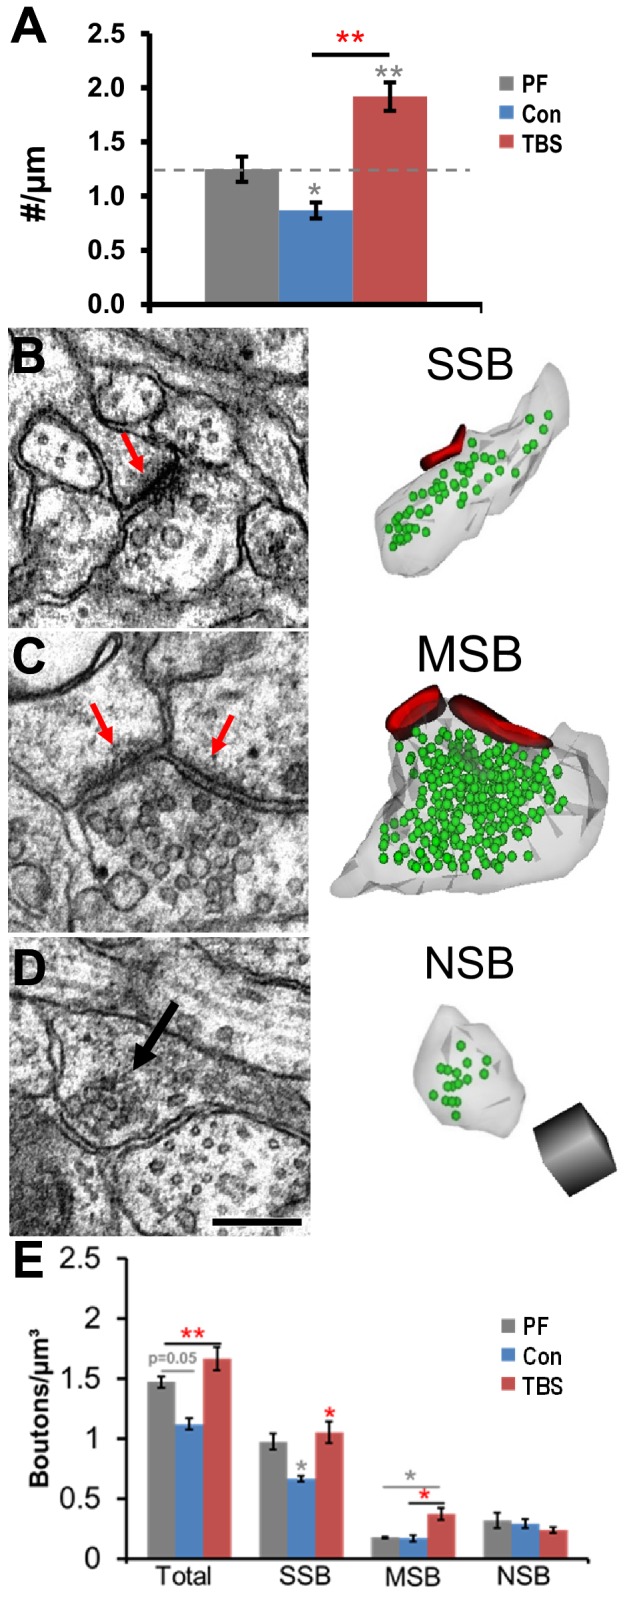
Maintenance of SSBs and increase in MSBs following induction of LTP by TBS at P15.(A) Spine density (#/µm length of reconstructed dendrite) from perfusion-fixed (PF) decreased under control stimulation (Con) and increased at 120 min after TBS induction of LTP (F
(2, 60)=26.45, p<0.0001, adapted from Watson et al., 2016). Example electron micrographs and 3D reconstructions of: (B) SSB with one PSD (red arrow), (C) MSB with two synapses (red arrows), and D) NSB (black arrow) with 16 vesicles but no postsynaptic partner. Reconstructions have PSDs (red), synaptic vesicles (green), and axonal plasma membranes (translucent gray). In D (for B–D), the scale bar is 0.25 µm and the scale cube is 0.25 µm on each side. (E) Overall, the frequency (boutons/µm3 of unbiased bricks) of presynaptic boutons was significantly greater at 120 min following TBS induction of LTP, relative to PF and Con conditions (F = 11.312, df = 2, p<0.01). There were fewer SSBs under control conditions compared to PF, whereas SSB frequencies were maintained at PF levels following TBS and were significantly greater than controls (F1,6 = 14.6, p=0.0087). MSB frequencies were greater following TBS than controls or PF (F1,6 = 10.1, p=0.012). The NSB frequencies did not differ significantly across conditions (F1,6 = 0.32, p=0.59). Two unbiased bricks (see Materials and methods) were analyzed per series for a total of 546 boutons across conditions (Table 1). Significant post hoc differences are indicated as *p<0.05, **p<0.01, ***p<0.001, and ****p<0.0001.